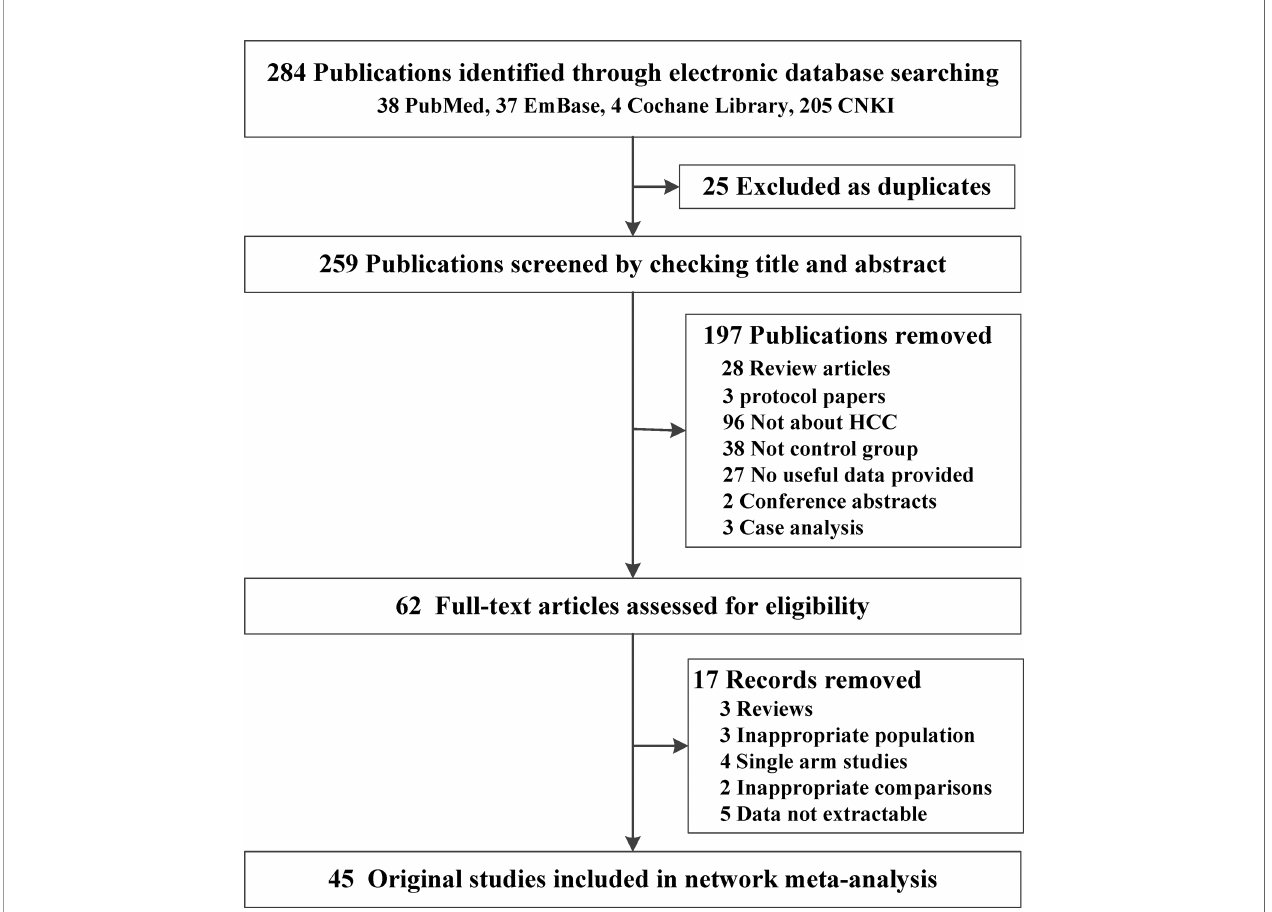
FIGURE 1 | Flow chart of studies included in the review of TACE + apatinib versus TACE studies. HCC, hepatocellular